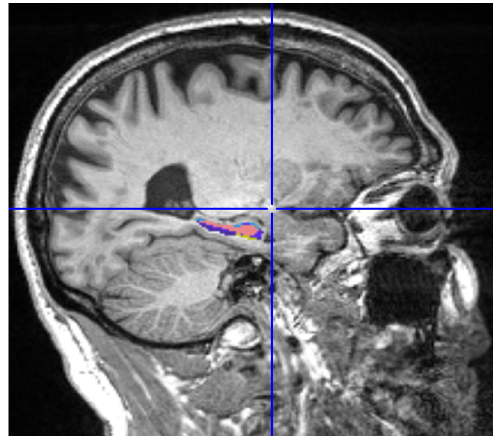
Figure 2. Functional block scheme of volBrain.